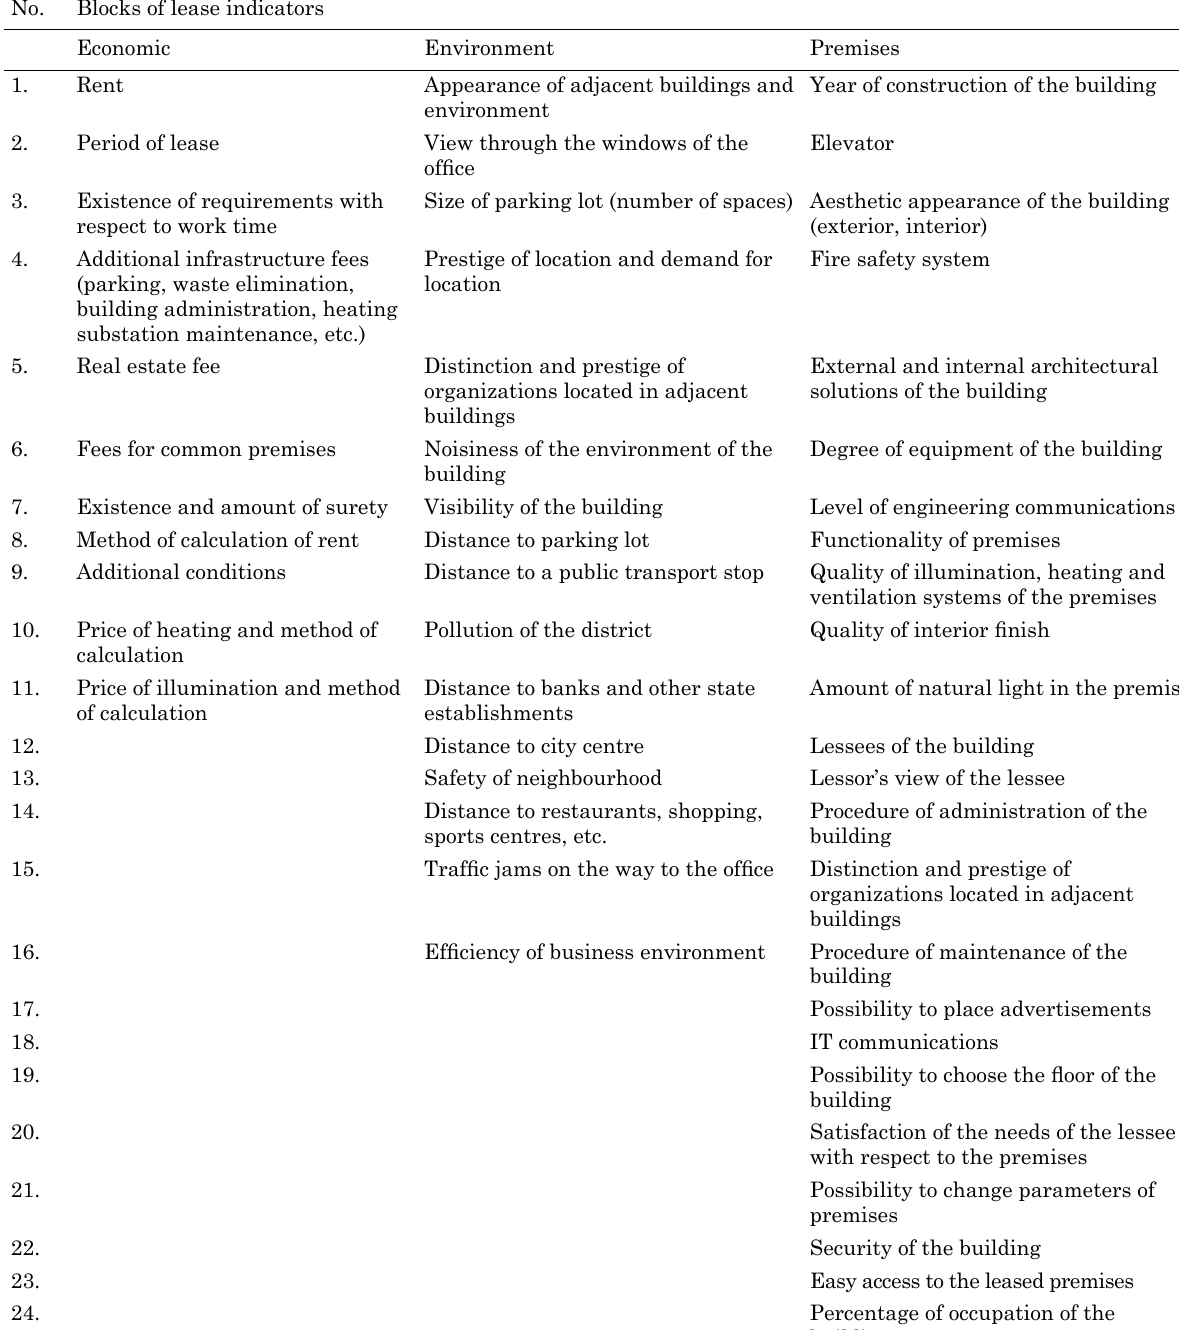
Table 13. System of indicators for commercial real estate object (office) leasing